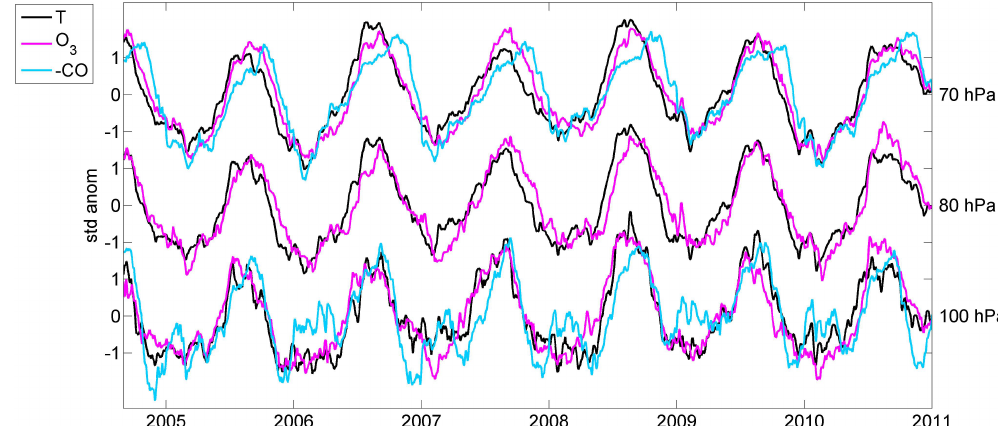
Fig. 1. Time series of standardized anomalies of daily temperatures from ERA-Interim and ozone and CO mixing ratio measurements from MLS averaged over 18 ◦ N–S at three pressure levels across the tropical tropopause (70, 80 and 100hPa from top to bottom; levels shown for MLS are 68, 83 and 100hPa). 3-days running means are applied to the daily series. CO concentrations are plotted on a reversed scale in order to highlight the common